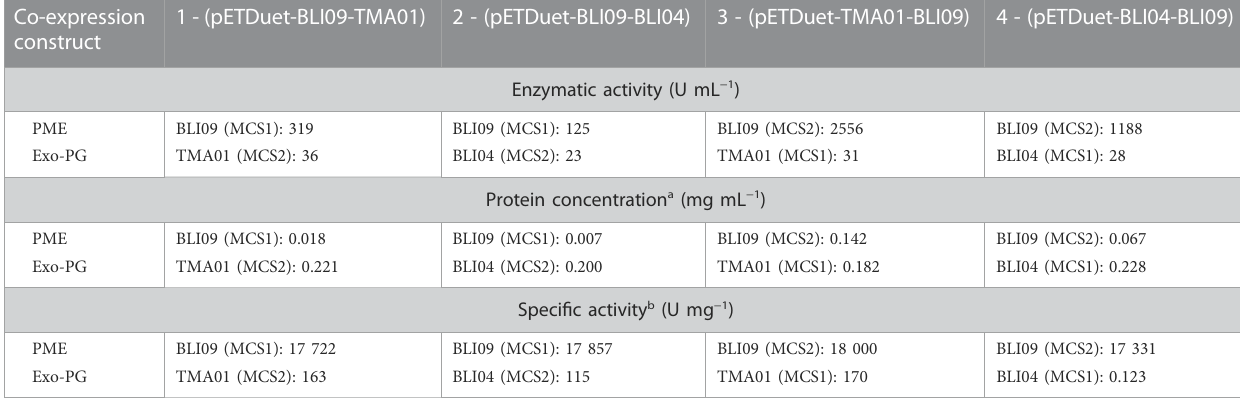
TABLE1Comparisonofproteinconcentrationsandenzymaticactivitiesbetweenpuri fi edpectinases(BLI09,TMA01andBLI04)fromtheconstructedco-expression constructs. Co-expression